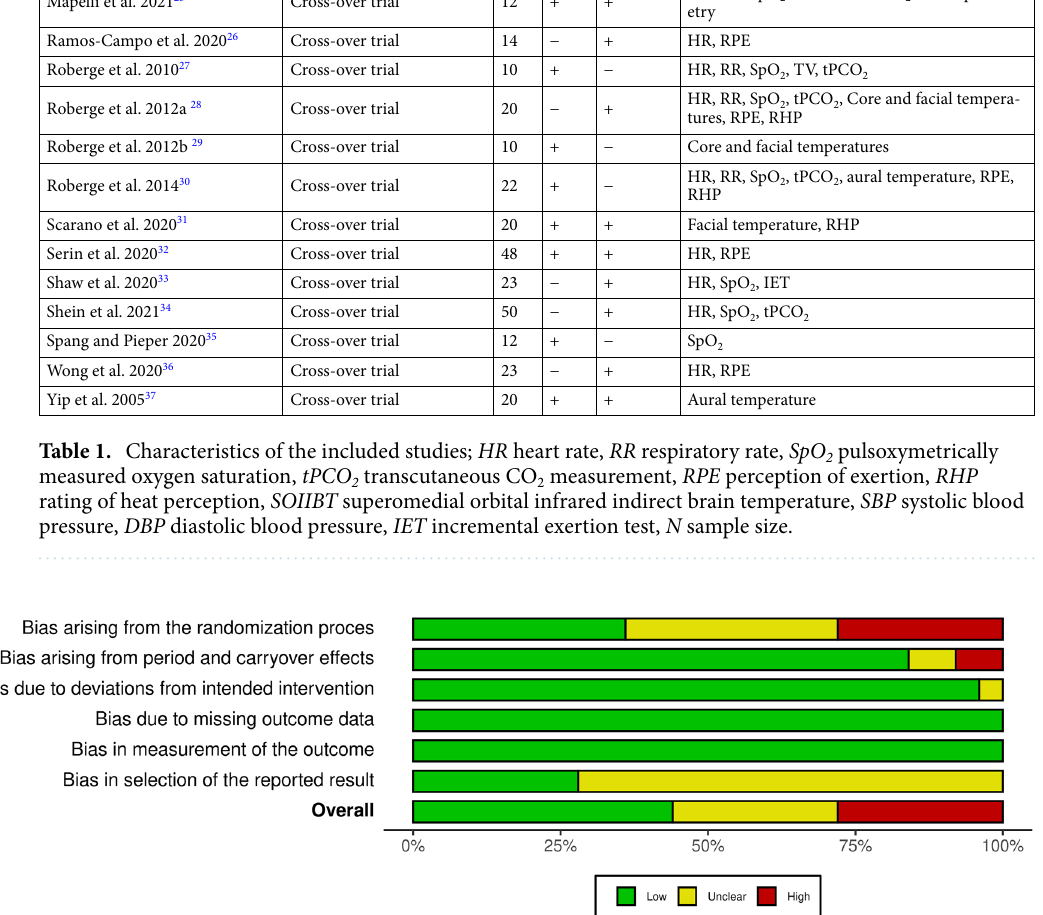
covered by a mask, and subjective rating of heat perception (RHP)) during low-intensity activities. Statistically significant comparisons are depicted in Fig. 3. Seven additional pairwise meta-analyses (Supplementary Fig. 3) were performed examining the effects of N95 FFRs and surgical masks on HR, RR, TV, oxygen uptake (VO 2 ), ventilation (VE), and on the perception of exertion (RPE) during moderate or high-intensity exercise. To com- pare the sizes of the effect of surgical masks and N95 FFRs seventeen network meta-analyses were performed